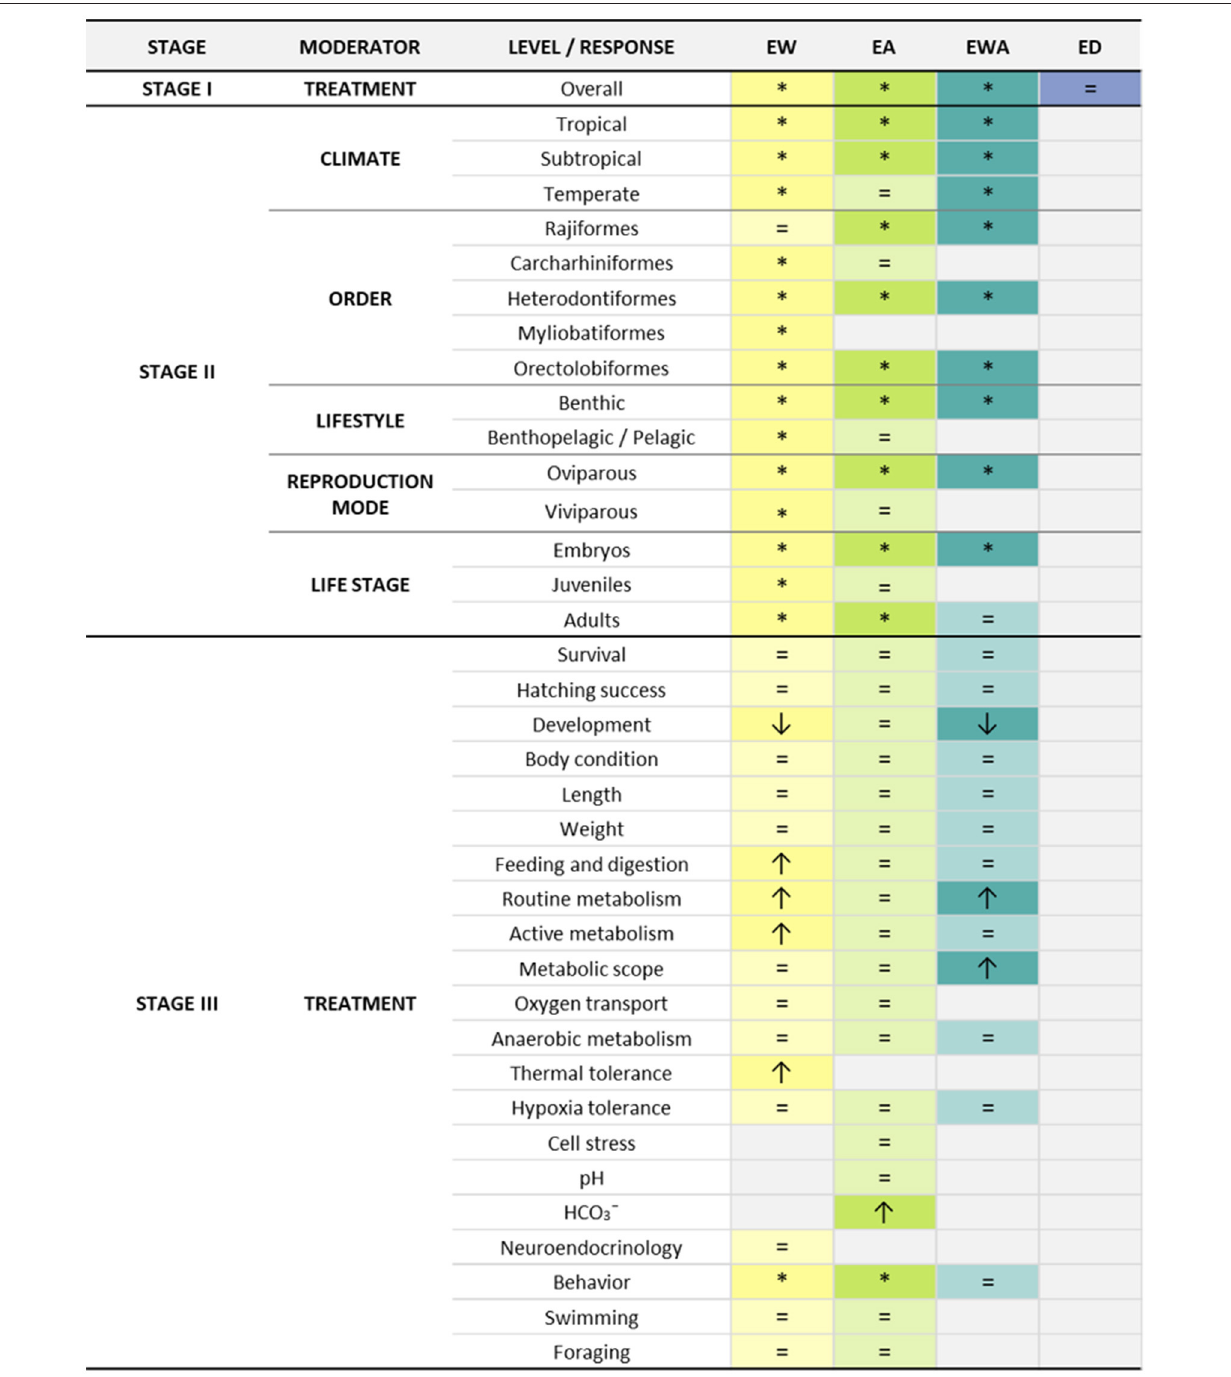
FIGURE 7 | Summary the results obtained in the different stages of the analysis the effects of experimental warming (EW), acidification (EA), deoxygenation (ED), and the combination of warming and acidification (EWA) over elasmobranchs. Asterisks (*) indicate significant impacts over combined biological response in terms of absolute change (Stage I and II). Arrows indicate the direction of effects [stimulation ( ↑ ) or inhibition ( ↓ )] over specific biological responses (Stage III). Equals sign ( = ) indicates the lack of significant effects. Empty cells identify responses not assessed due to data